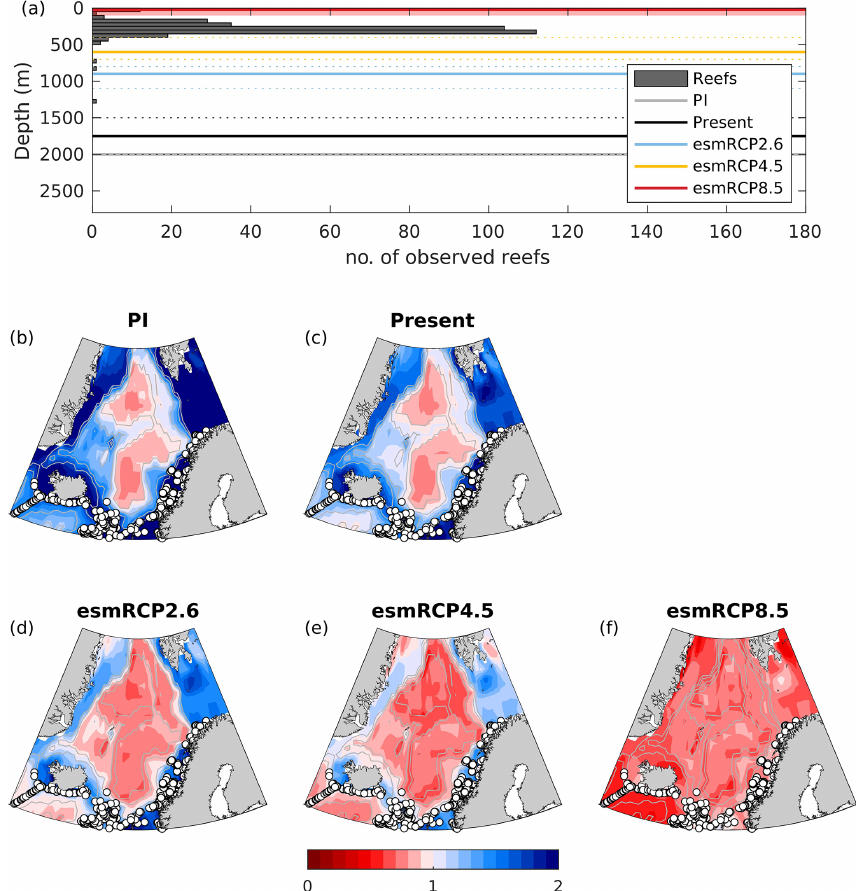
Figure 12. The number of observed reef sites per 50m depth interval together with the aragonite saturation horizons (solid lines) in the Nordic Seas for the past (1850–1879), present day (1980–2005), and future (2070–2099) under the esmRCP2.6, esmRCP4.5, and esmRCP8.5 scenarios calculated from the GLODAPv2 climatology and NorESM1-ME simulations. The dashed lines show the uncertainty ( σ field ). The red shading shows the projection uncertainty, as estimated from our ESM ensemble for esmRCP8.5 (a) and maps showing aragonite saturation state of bottom waters (calculated from the GLODAPv2 climatology and NorESM1-ME simulations), together with positions of observed reefs (b–f)